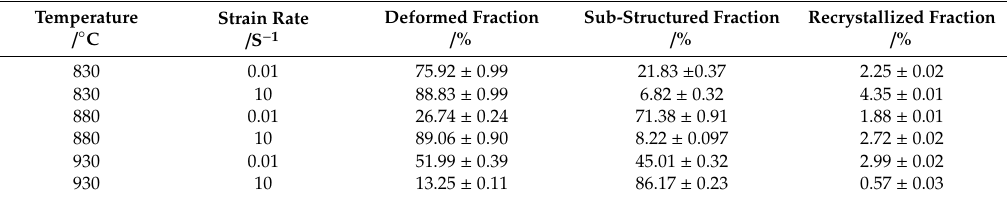
Table 2. Fractions of recrystallized, sub-structured, and deformed grains in the specimens deformed at di ff erent conditions of β phase